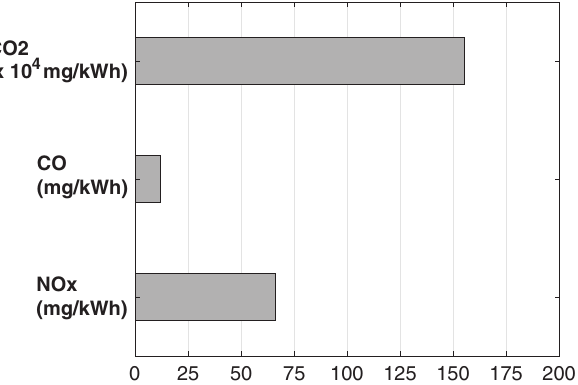
Figure 18. Emissions in the exhausts of a 5650 W FPSE in nominal conditions. Table 4 collects the main environmental data of the technologies for remote power generation in the gas grid. Table 4. Environmental features of TEGs, SOFCs, SAFCs, DMFCs, FPSEs and MTs.